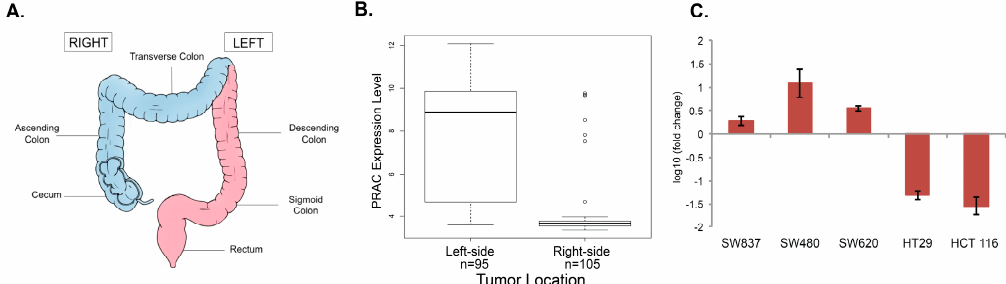
Figure 2. ( A ) Illustration of the human colon and rectum to denote right-sided colon cancer (RCC) from left-sided colon cancer (LCC); ( B ) Expression levels of the prostate cancer susceptibility candidate (PRAC) (230784_at) by tumor location in the GSE14333 microarray data. PRAC is expressed at a high level in most left-sided tumors and at a baseline level in most right-sided tumors; ( C ) qRT-PCR of PRAC expression in DLD-1, SW837, SW480, SW620, HT29, and HT 116 cells. PRAC mRNA levels were quantified using the comparative C T method relative to mRNA levels of hypoxanthine phosphoribosyltransferase 1 (HPRT1). The fold change in expression (log 10 ) was normalized to DLD-1 mRNA levels and is shown in the bar graph with the error bars representing the standard deviation.